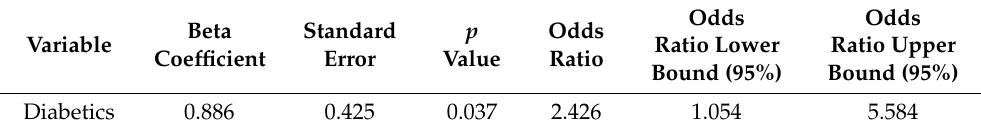
Table 4. Multivariate logistic regression to identify significant risk factors for moderate/severe